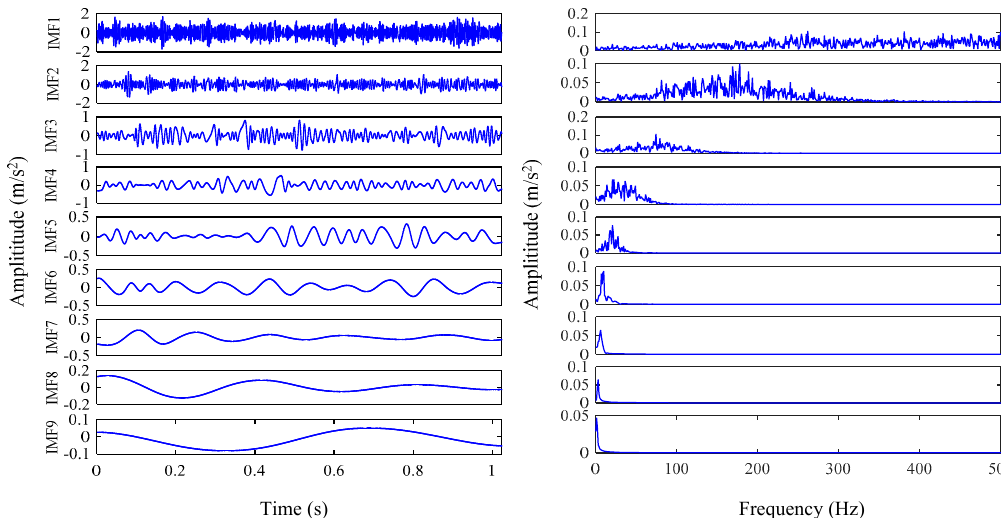
Figure 4. Decomposition results and corresponding frequency spectrum of intrinsic mode functions (IMFs) with Empirical Mode Decomposition (EMD).